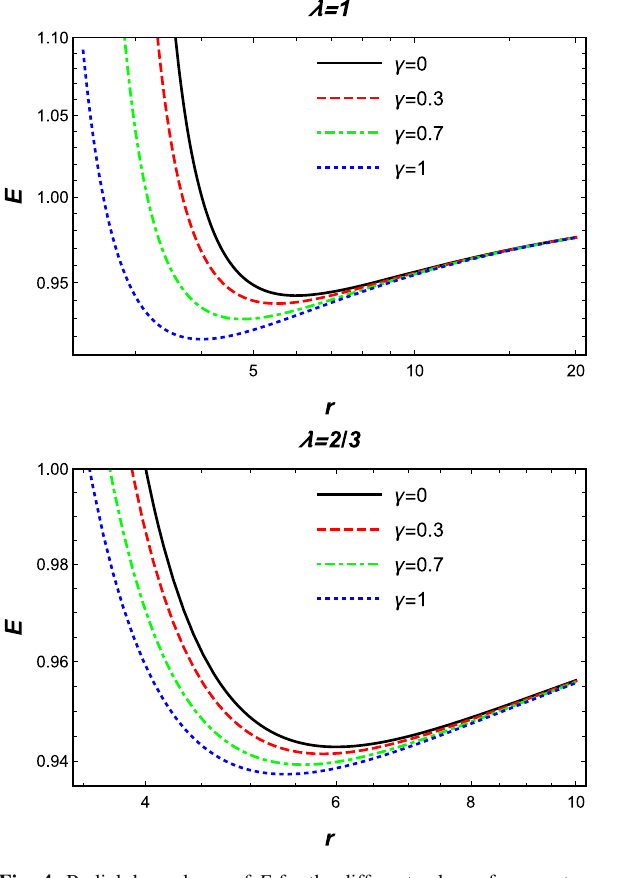
Fig. 4 Radial dependence of E for the different values of parameters γ and λ . Where M = m = 1